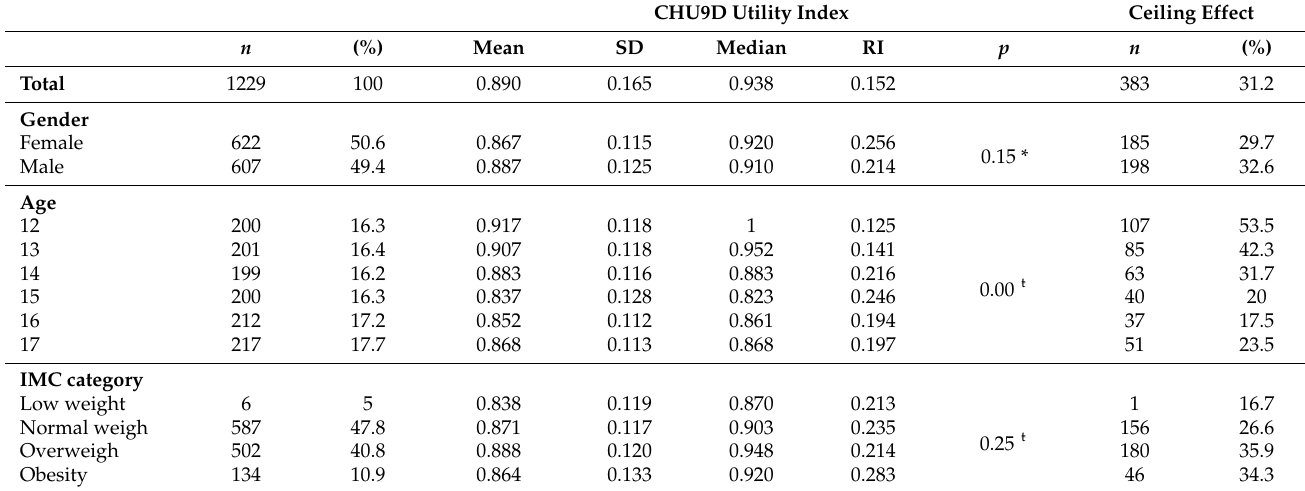
Table 1. Sample characteristics. CHU9D adolescents’ population normative values.